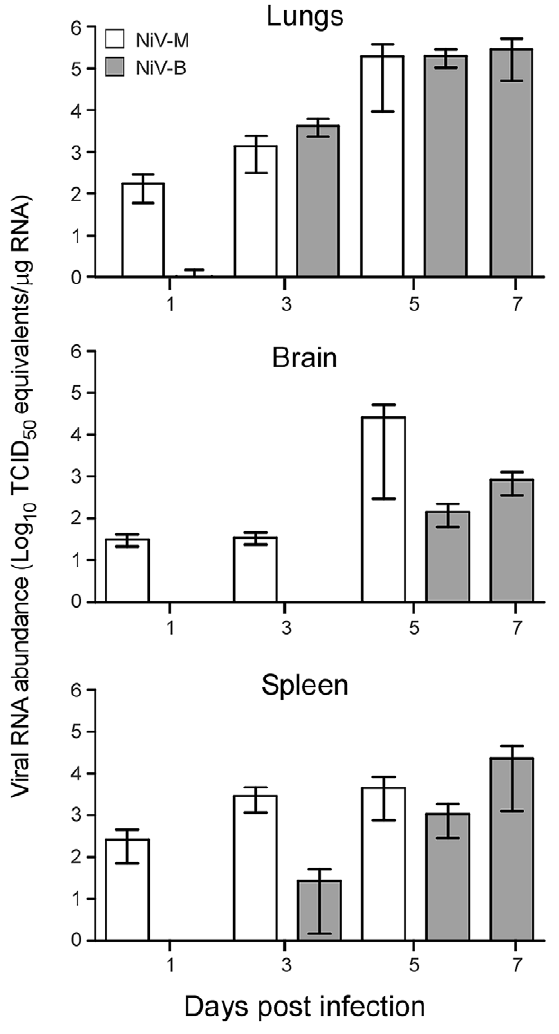
Figure 3. NiV-B replication is delayed in hamster organs compared to NiV-M replication. Hamsters were inoculated with 10 5 TCID 50 of Nipah virus and 9 animals/group were euthanized at 1, 3, 5, and 7 (for NiV-B only) dpi and tissues were collected. Total viral RNA was extracted and Nipah virus N-specific viral RNA was quantified by qRT-PCR. Gray bars represent NiV-B and white NiV-M. Bars represent the mean and error bars represent the SEM.